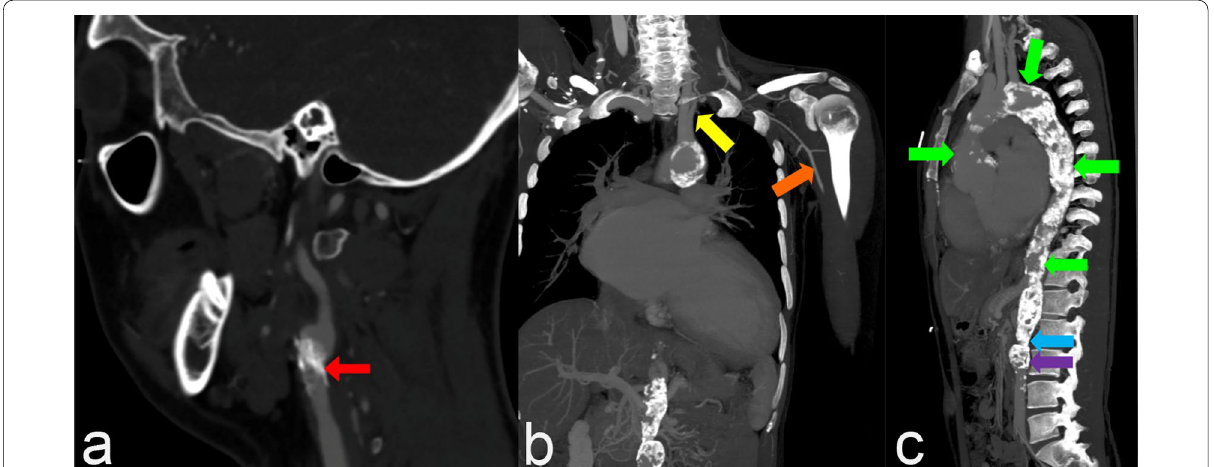
Fig. 2 CTA examination showed a calcification in the left common carotid artery (red arrow) leading to stenosis; b total occlusion of the left subclavian artery (yellow arrow) with the left axillary artery (orange arrow) receiving vascularization from the collateral artery of the common carotid artery; ( c ) calcification of the peri-aortic valve, ascending aorta, aortic arch, descending aorta, and abdominal aorta (green arrow) with high-grade stenosis on the inferior side of the renal artery branching (blue arrow) accompanied by a post-stenotic dilatation (purple